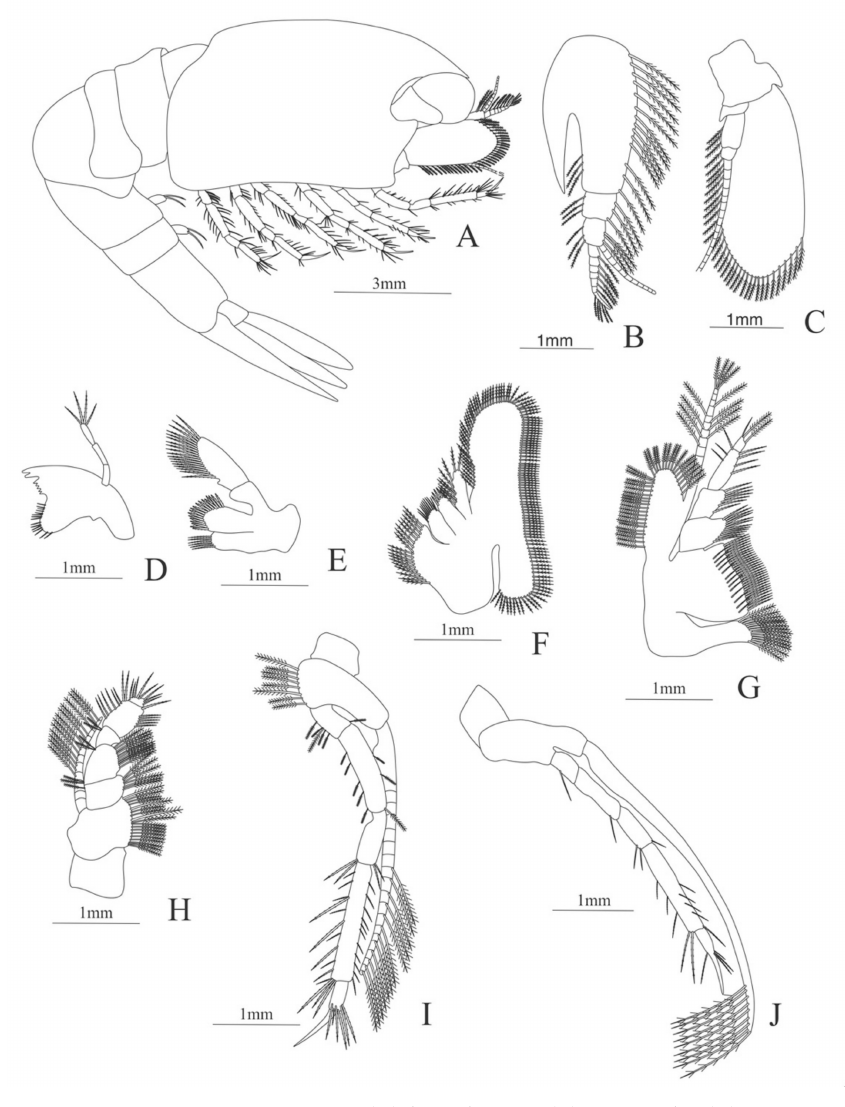
Figure 10. Eugonatonotus crassus : ( A ) lateral view; ( B ) antennule; ( C ) antenna; ( D ) mandible; ( E ) maxillule; ( F ) maxilla; ( G ) first maxilliped; ( H ) second maxilliped; ( I ) third maxilliped; ( J ) first